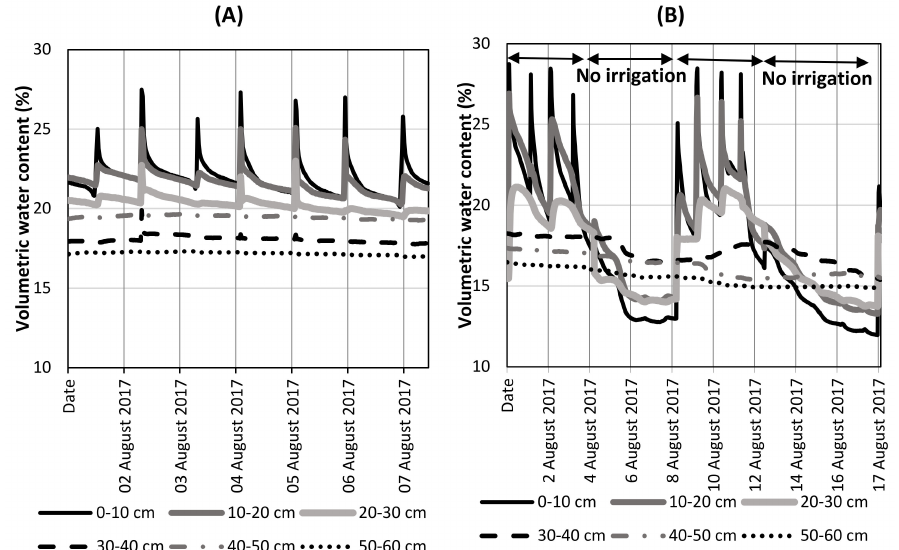
Figure 4. Pattern of soil volumetric water content for ‘Orogrande’ clementine during one week for regulateddeficitirrigation(RDI)-1( A );periodof1Augustto7August)andtwoweeks(i.e.,twoirrigation cycles) for partial rootzone drying (PRD)-3 / 4 ( B ); period of 1 August to 17 August) treatments according to soil depth. Arrows indicate alternating irrigation and no-irrigation cycles. Measurements were recorded every 15 min using capacitance probes.